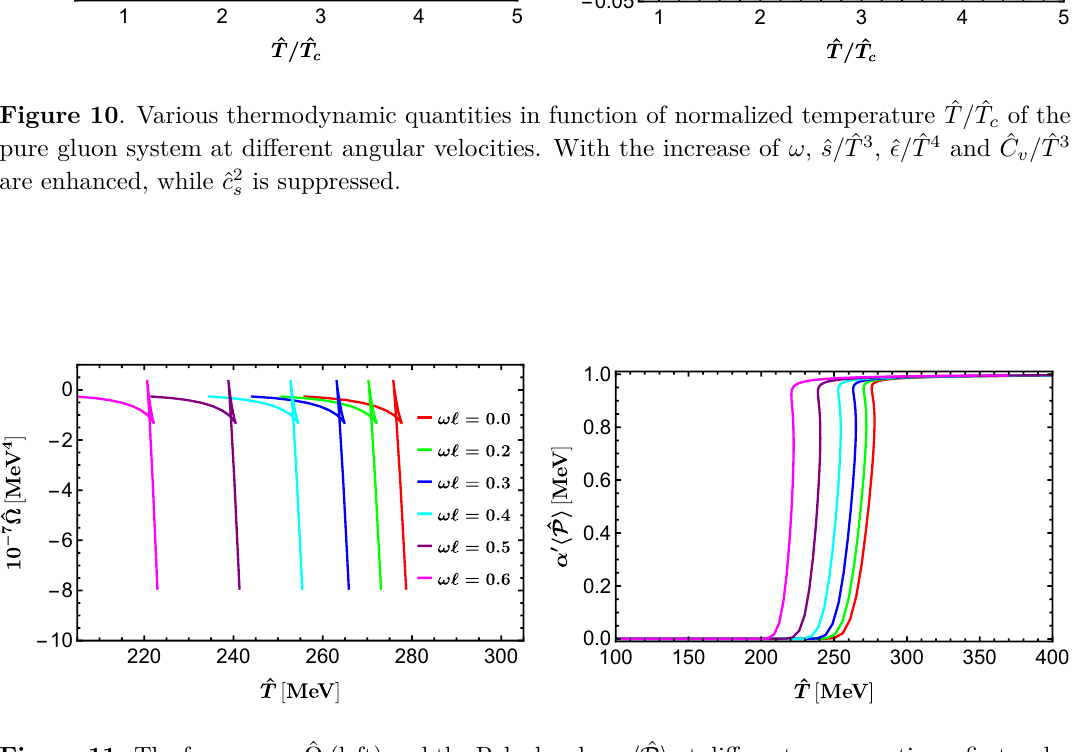
Figure 11 . The free energy ˆΩ (left) and the Polyakov loop h ˆ Pi at different ω , suggesting a first-order deconfinement phase